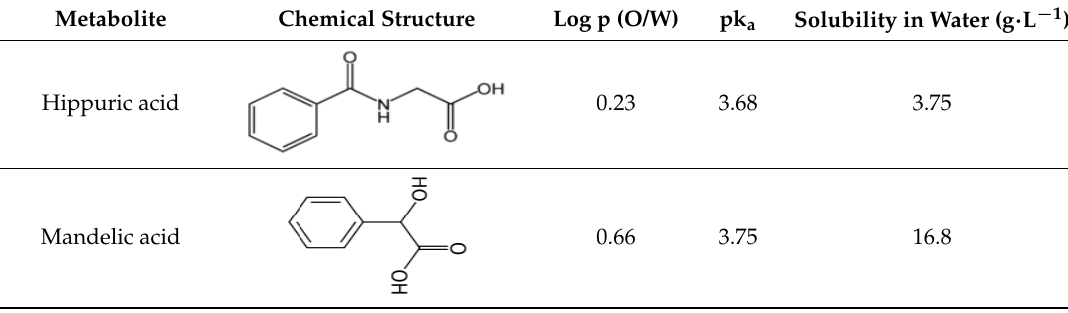
Table 1. The structures and physicochemical properties of toluene and ethylbenzene